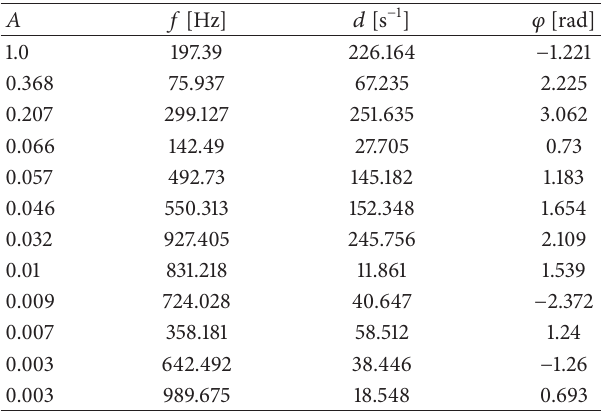
Table 1: Parameters of all EDS extracted by the MPM algorithm from the resonant percussion signal of Figure 1(a).